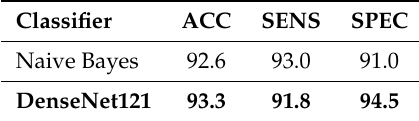
Table 3. Comparison with article [13]